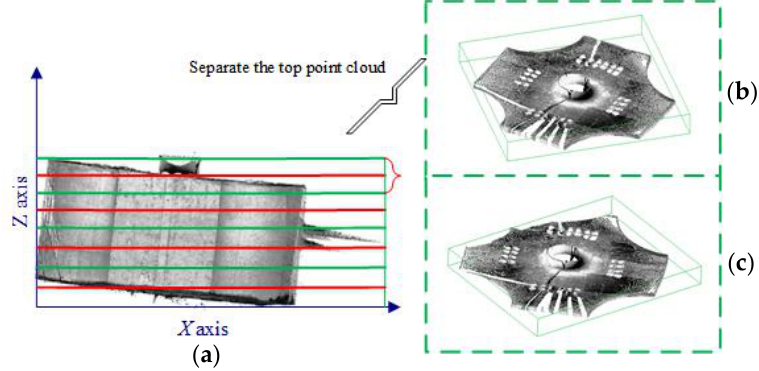
Figure 5. Separation of the top point cloud. ( a ) Front view, ( b ) Complete top point cloud, and ( c ) Incomplete top point cloud.